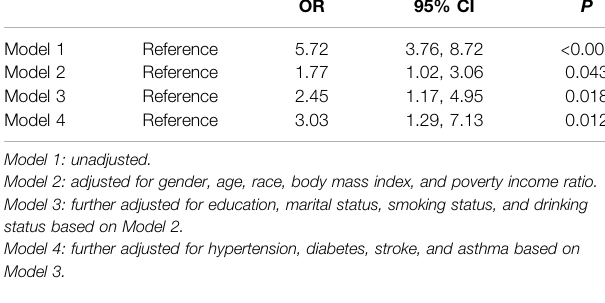
TABLE 3 | Weighted logistic regressions of associations between periodontal status and heart failure.